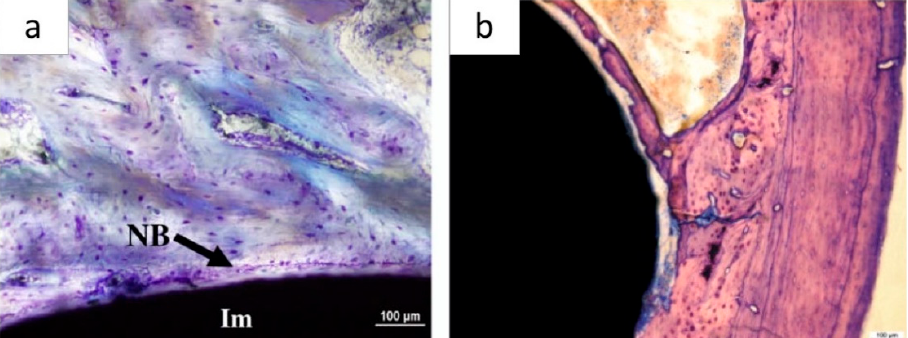
Figure 6. Histological morphology of the interface between the implant and the bone tissue of: ( a ) sphene-coated Ti-6Al-4V implant after six weeks of healing (Toluidine blue); from Ramaswamy et al., 2009 [137]; ( b ) stainless steel implant coated with hybrid organic-inorganic bioactive coating containing wollastonite after 60 days of healing (Toluidine blue); from Ballarre et al., 2011 [157]. Im, implant; NB, new bone.